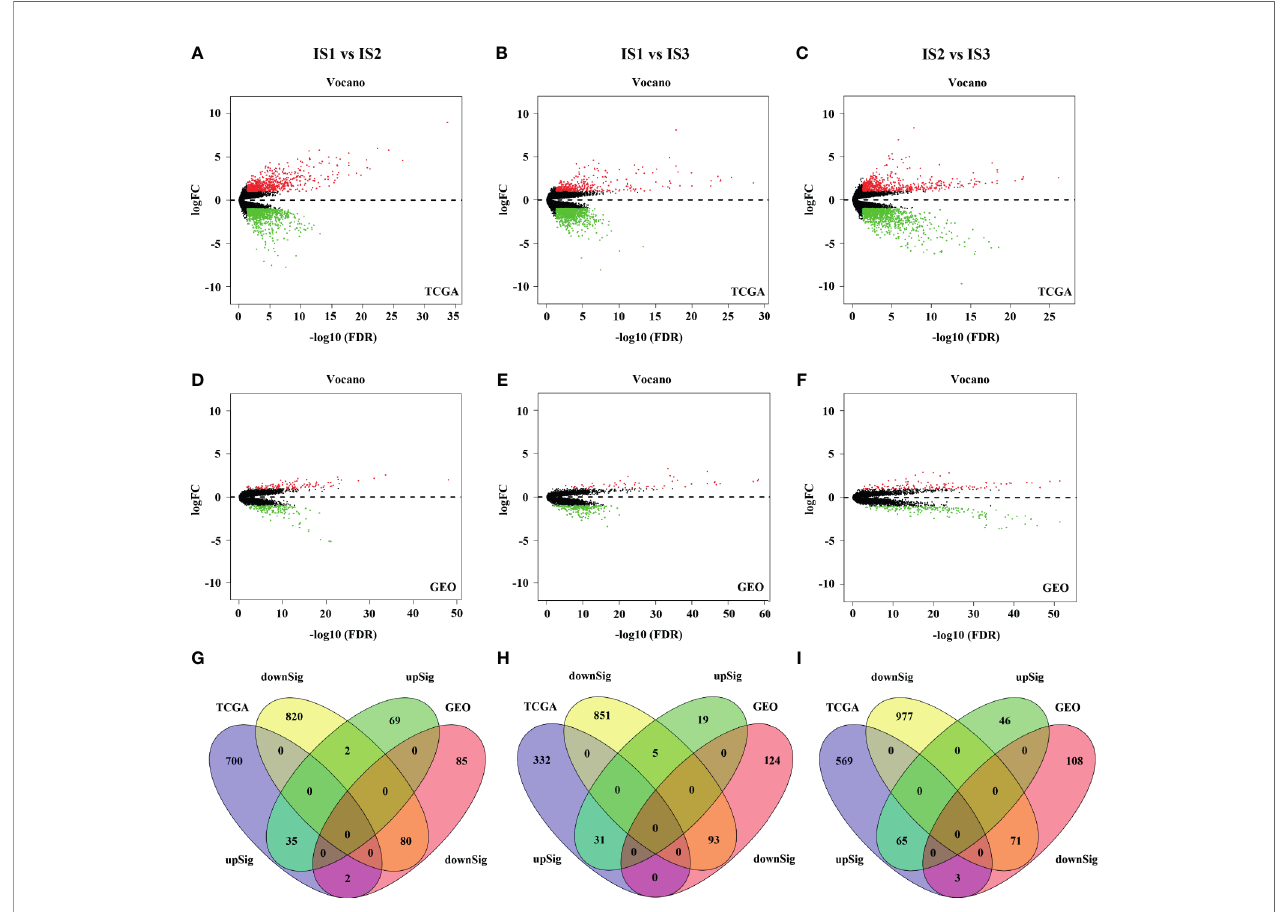
FIGURE 4 | The results of differential expression analysis in the TCGA and GEO cohort (A – F) . 115 DEGs was found in IS1 vs IS2 (G) . 124 DEGs was found in IS1 vs IS3 (H) . 136 DEGs was found in IS2 vs IS3 (I)